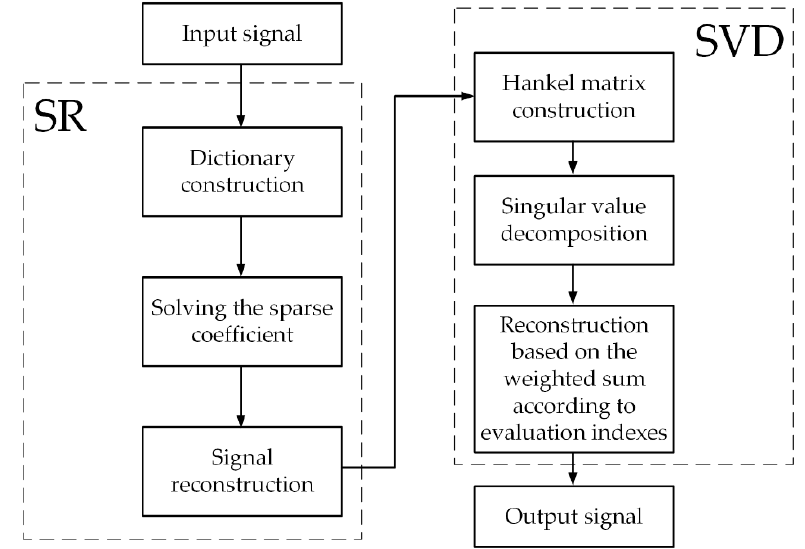
Figure 2. Flowchart of SRSVD.